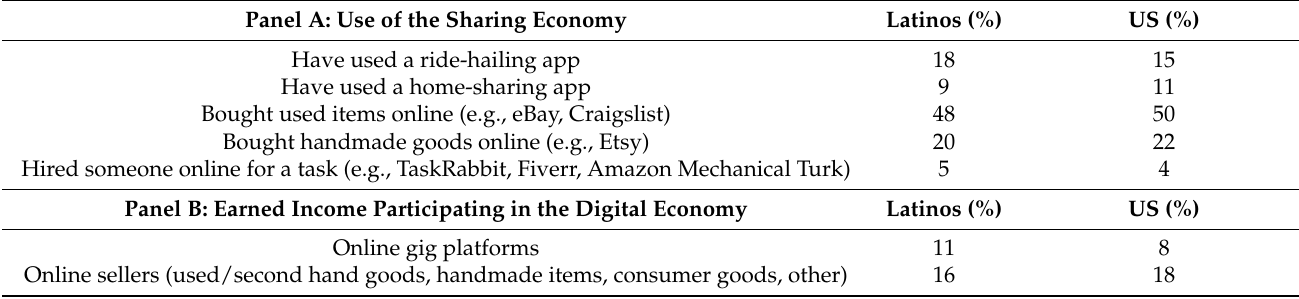
Table 1. Use of and Participation in the Sharing